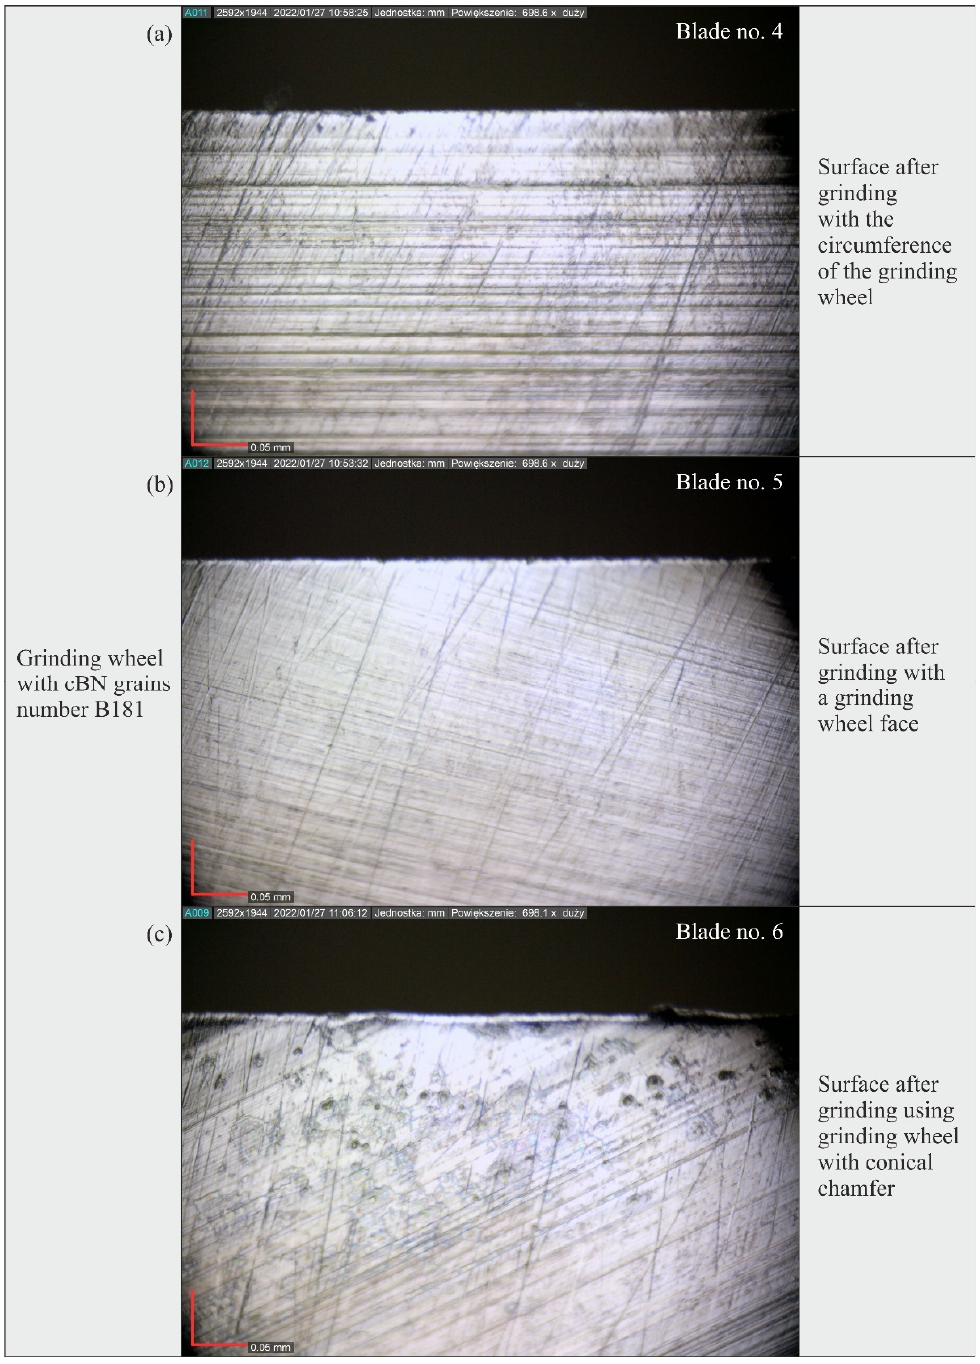
Figure 20. Microscopic views of the blade surface of planar knives shaped using grinding wheels with cBN abrasive grains numbered B181 at a magnification of approximately 700×: ( a ) surface after peripheral grinding (blade no. 4); ( b ) surface after face grinding (blade no. 5); ( c ) surface after grinding using grinding wheel with conical chamfer (blade no. 6).